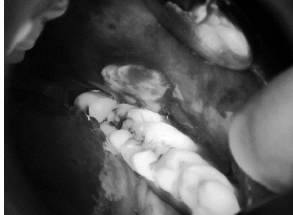
Figure 17. Region edge detected using Deriche–Canny edge detector.